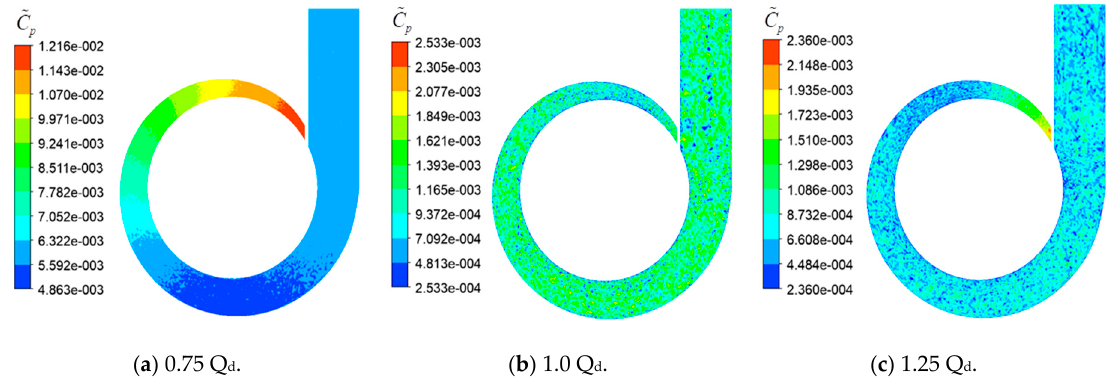
Figure 21. Pressure fluctuation distributions at the mid-span of the volute.